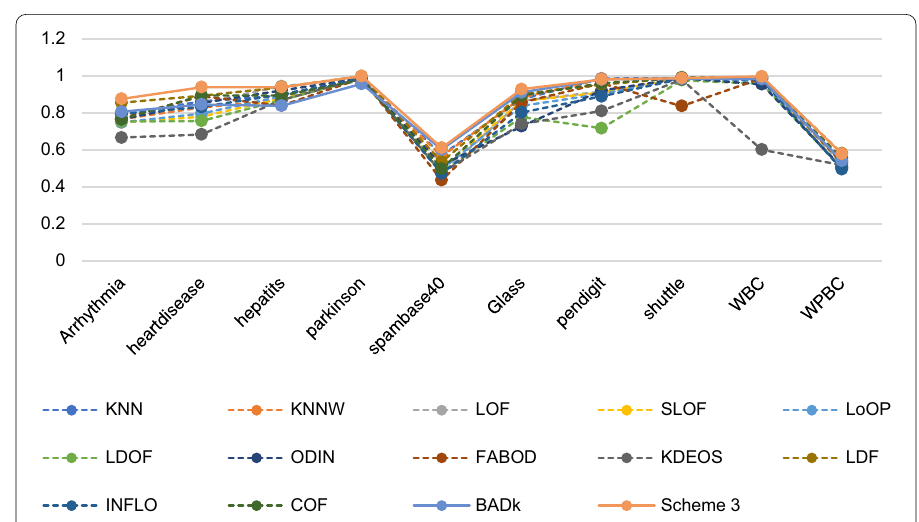
Fig. 15 Comparison of the proposed schemes with the state-of-art methods using 10 benchmark datasets for outlier detection. Y-axis represents the computed ROC AUC